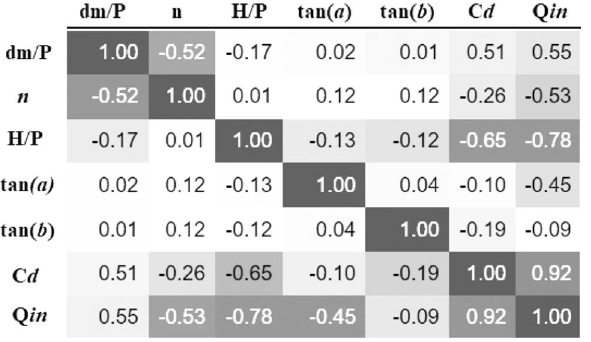
Fig. 4 Correlation Matrix for Different features in the